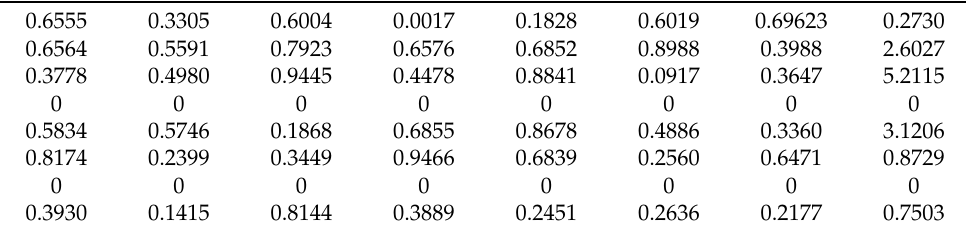
Table 6. Optimized weights for Type 1 failure for the PS method.